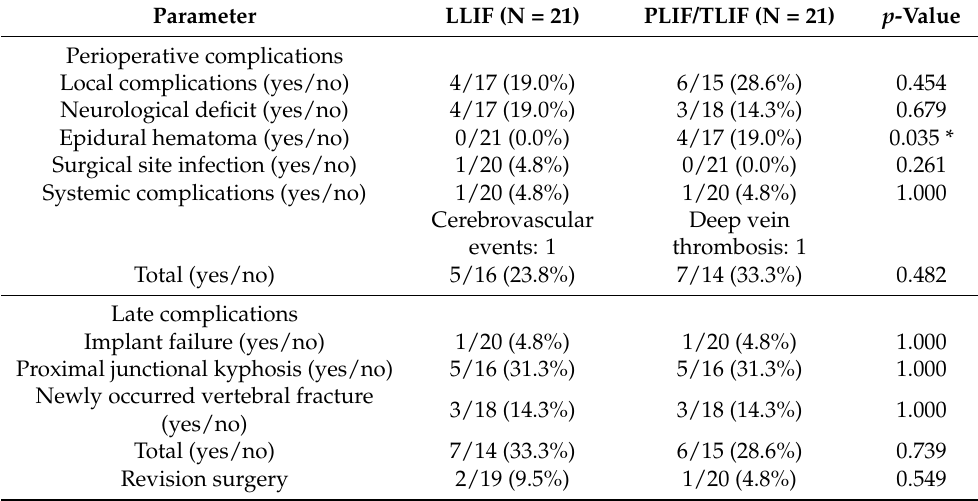
Table 4. Surgical complications of the LLIF group and the PLIF/TLIF